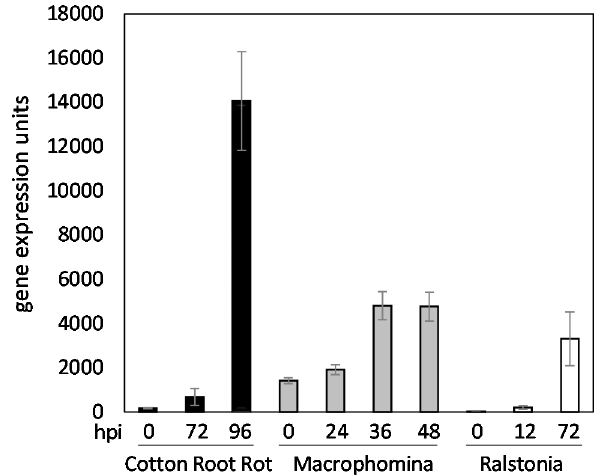
Figure 2. ChOMT1 expression in pathogen-inoculated roots of Medicago truncatula . Data are taken from the Medicago Gene Expression Atlas [79]. Original data for Cotton Root Rot ( Phymatotrichopsis omnivore ) are from Reference [80], and data for Macrophomina phaseolina were described by the authors of [81]. Data for Ralstonia solanacearum has not been described in a publication. hpi = hours post inoculation. Bars are SD.